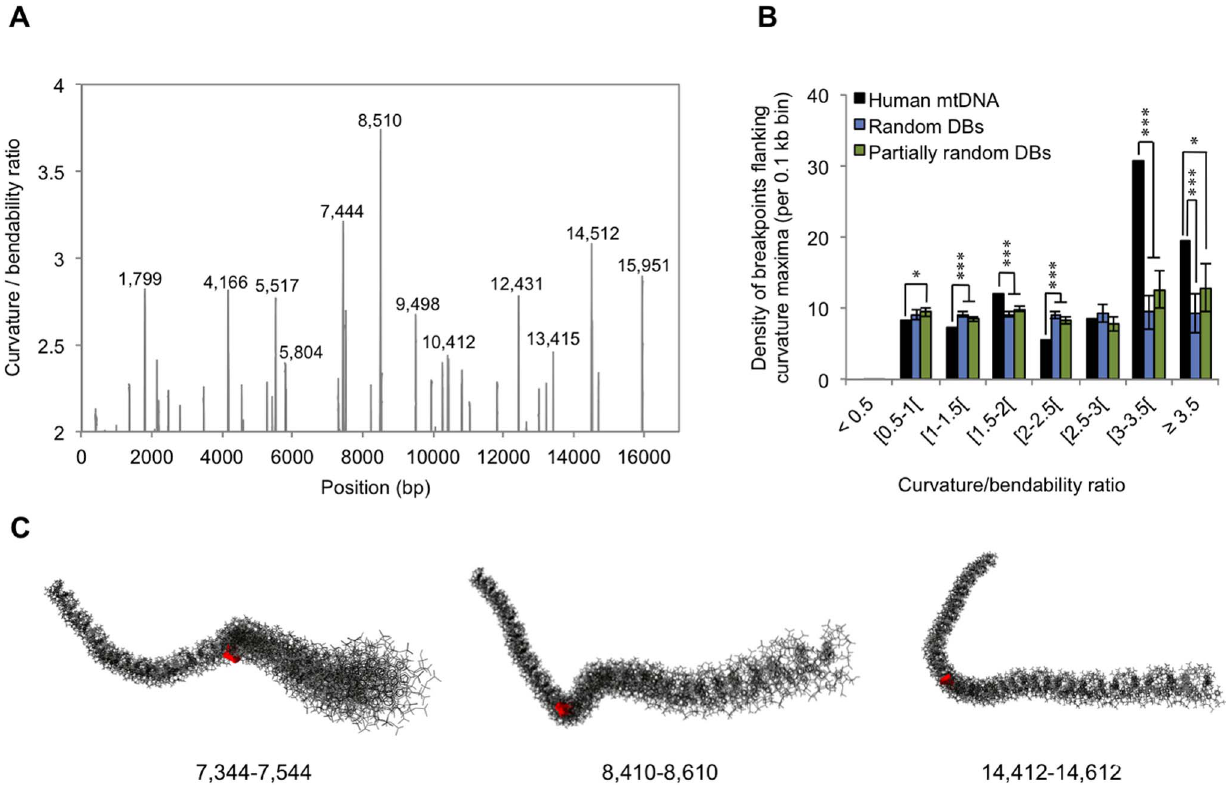
Figure 2. Impact of intrinsically bent DNA in the distribution of deletion breakpoints. (A) Curvature/bendability profile of the entire mtDNA genome as computed by the bend.it algorithm (see Methods section). The exact positions corresponding to the highest curvature/ bendability ratios are indicated above the corresponding peaks. (B) Density of deletion breakpoints ( g number of breakpoints/ g fragment sizes) computed in 0.1 kb bins flanking each curvature maximum (black bars). Also shown are the density values computed after randomization of breakpoint positions (shown in blue) or after partially randomization of breakpoint positions (shown in green) (see also Methods section). (C) Three- dimensional representations of three 0.2 kb regions harboring highly curved sequences. The exact position corresponding to each curvature maximum is highlighted in red. Additional three-dimensional representations of the remaining peaks highlighted in (A) can be found as supplementary material (Fig. S1). Error bars represent standard deviations. * p , 0.05; *** p , 0.001.